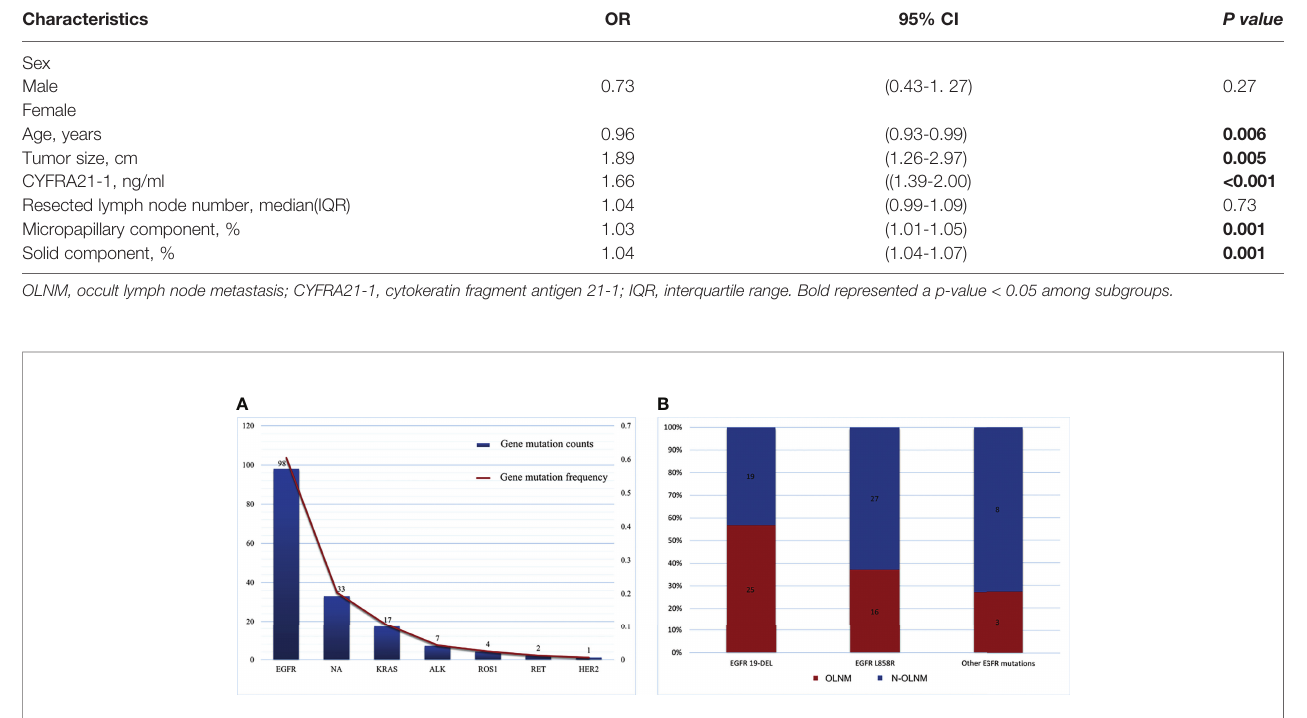
FIGURE 2 | Targeted genetic features detected by ARMS-PCR. (A) Gene mutation counts and frequencies of EGFR, KRAS, ALK, ROS1, and HER2; (B) Different distributions of EGFR exon mutations in OLNM and NOLNM groups. ARMS-PCR, ampli fi cation refractory mutation system-polymerase chain reaction; NA, no genetic mutations detected. OLNM, occult lymph node metastasis; NOLNM, non- occult lymph node